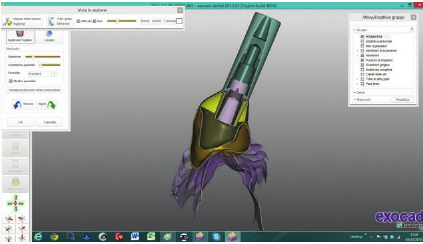
Figure 14: The definitive prosthetic crown was digitally drawn with Exocad DentalCAD platform.